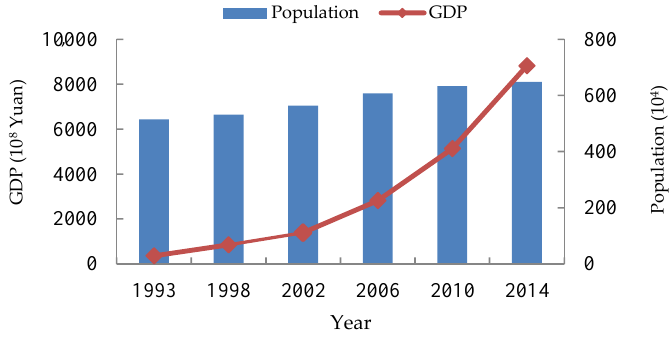
Figure 2. Population growth and economic development in Nanjing during 1993–2014.